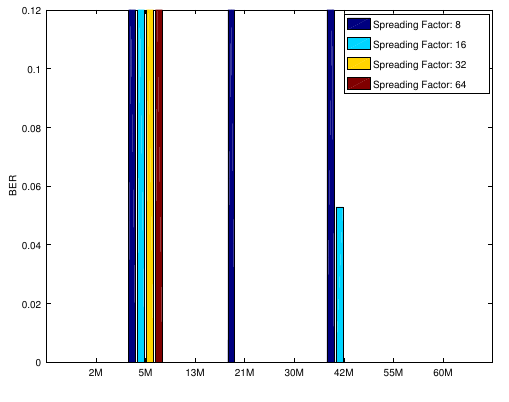
Figure 13: Plot of BER demodulation by the proto- type receiver. Loss of synchronisation is the cause of the large BER seen at